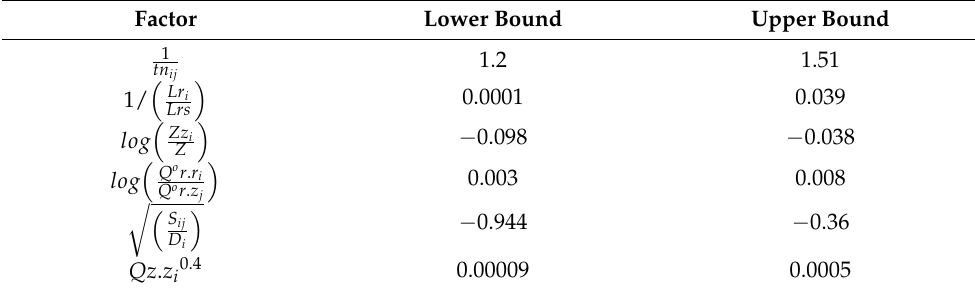
Table 3. Confidence intervals of the coefficients of the